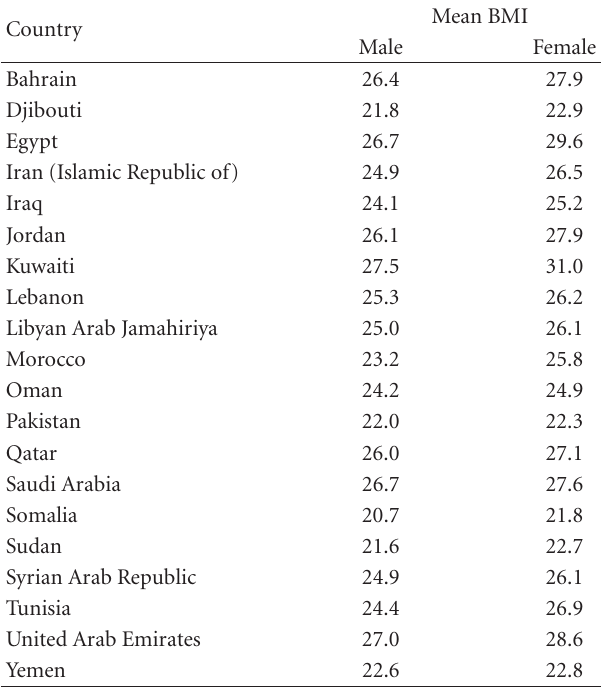
Table 4: BMI (kg/m 2 ) among adults in Eastern Mediterranean